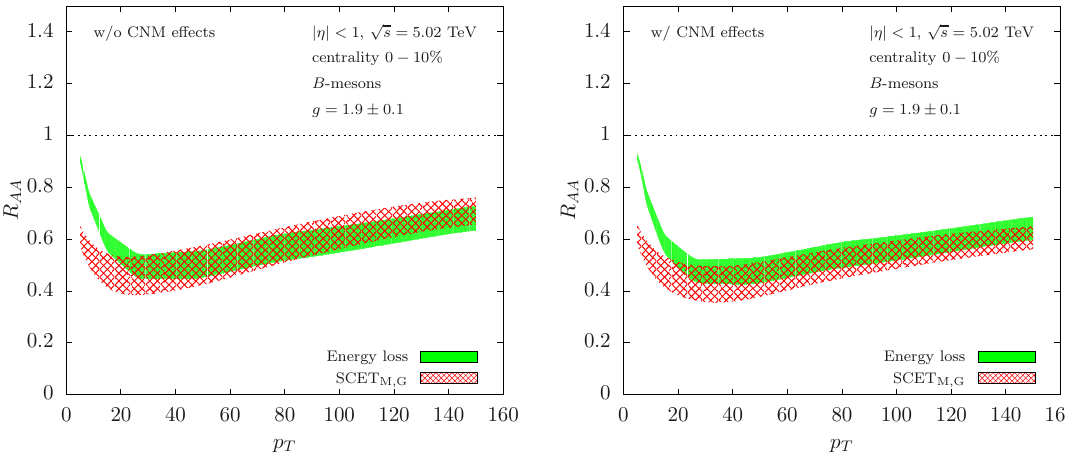
Figure 10 . Same as (cid:12)gure 9 but for B +